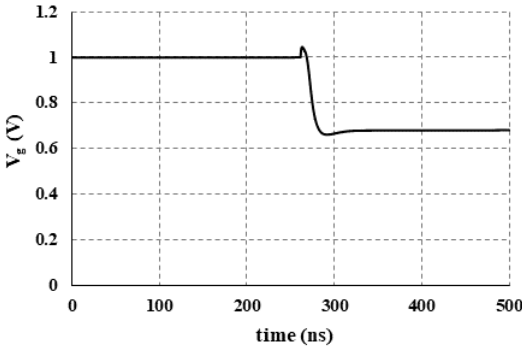
Figure 5. Variations of the gate voltage versus time in the proposed voltage controlled oscillator (VCO).